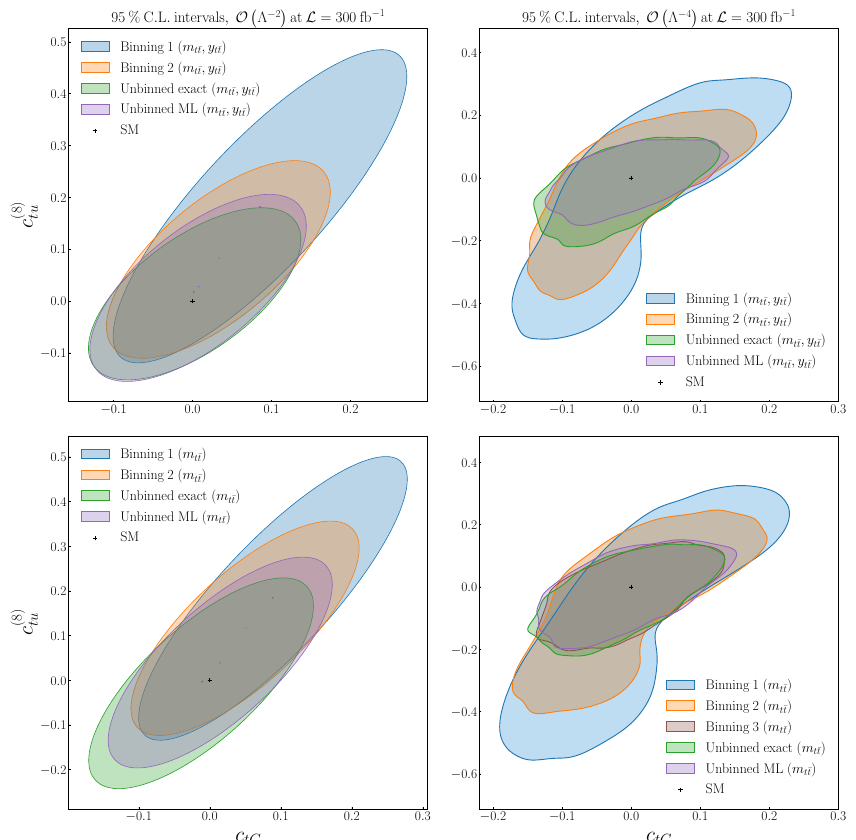
Figure 10. The 95% CL regions in the ( c tG , c (8) ) plane obtained for the parton-level top quark pair tu production process described in section 4.2. We present results based on EFT calculations at the linear level (left) and also including quadratic contributions (right panels). The black cross indicates the SM result, which is the hypothesis assumed in the generation of the pseudo-data that enters the inference procedure. We compare the results from two binned analyses (Binning 1 and 2) with those of the corresponding unbinned observable, constructed either with the analytic likelihood calculation or with its machine learning parametrization. We demonstrate how the analytical calculation is reproduced for a sufficiently fine binning (Binning 3). We display the contours corresponding to two different observables, the first built upon two kinematic features ( m , y ) (upper) and the second t ¯ t t ¯ t based on the invariant mass m as a single feature (lower t ¯ t